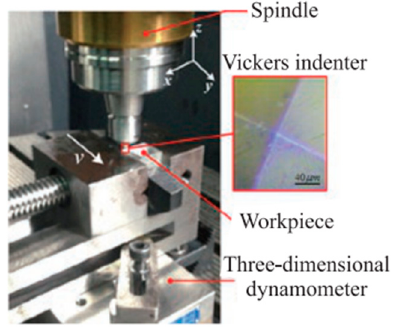
Figure 8. Experimental device (DMG,